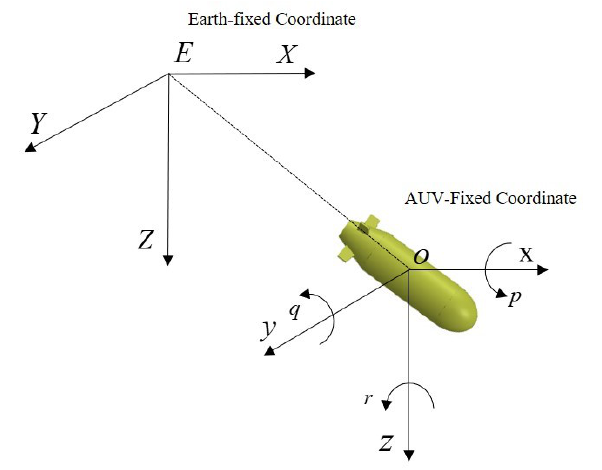
Figure 1. AUVs with body and earth-fixed reference frames.